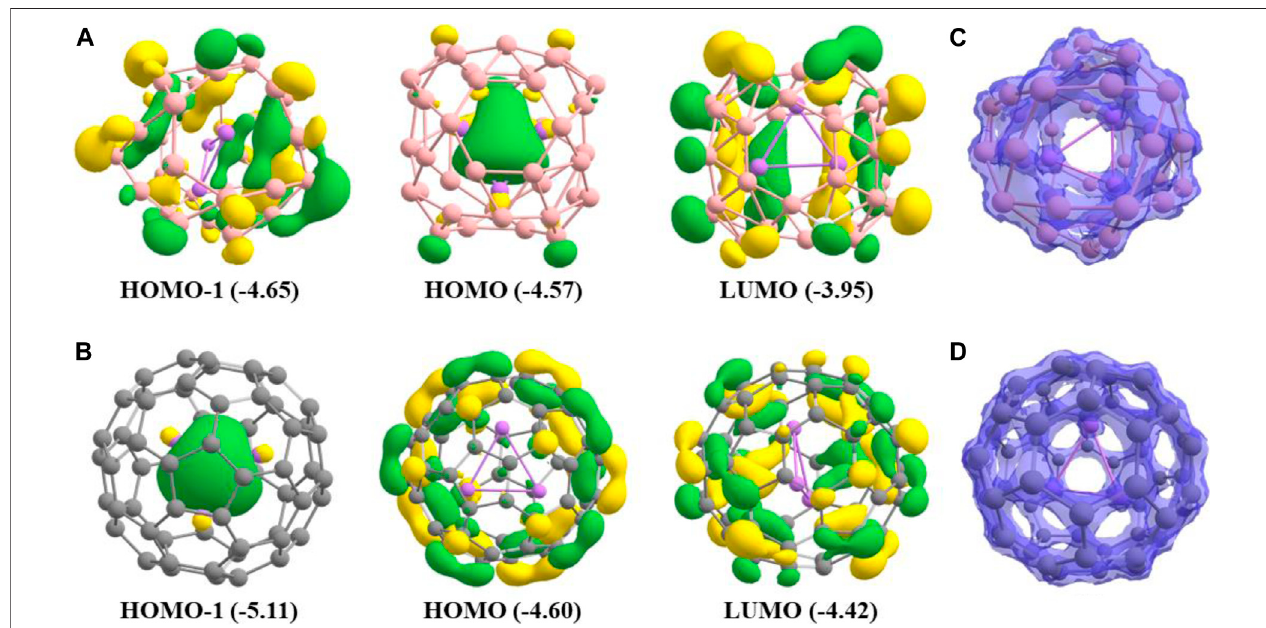
FIGURE 6 | Plots of the HOMO-1, HOMO, and LUMO for (A) Li 3 @B 40 system, (B) Li 3 @C 60 system, (C) and (D) are spin density for Li 3 @B 40 and Li 3 @C 60 system, respectively. The values in the parenthesis are the energies of the corresponding orbitals in the eV unit.